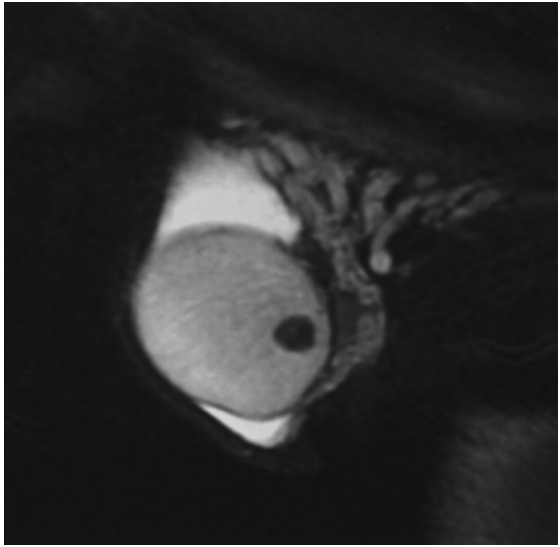
FIGURE 2A. The lesion demonstrates low signal intensity on T2-weighted